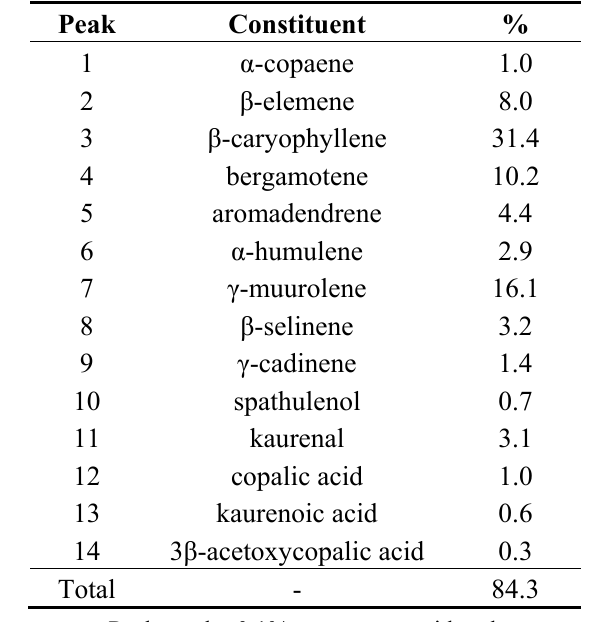
Table 1. Chemical composition of oleoresin from C. langsdorffii obtained by high-resolution gas chromatography.